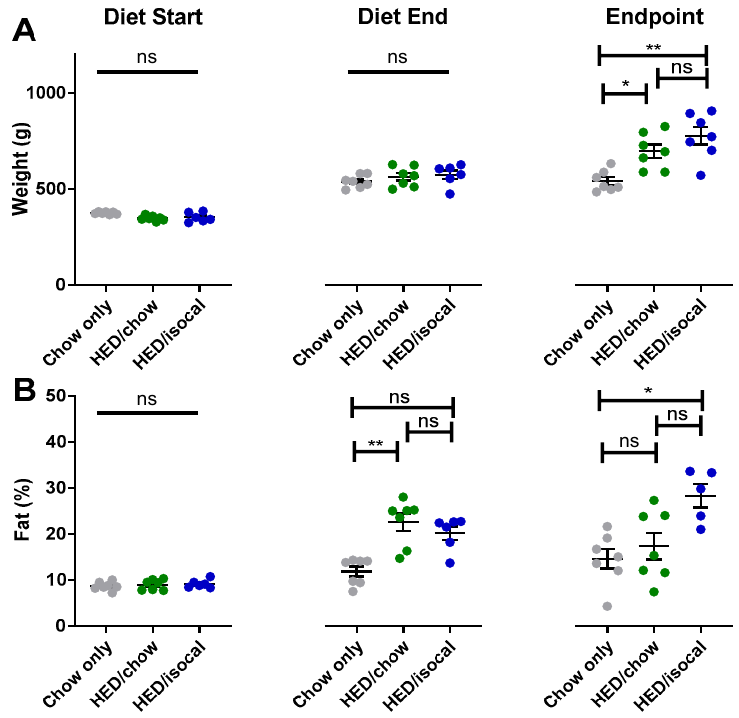
Figure 1. ( A ) Weight (g) of chow-only (grey, n = 7), HED/chow (green, n = 7) and HED/isocal (blue, n = 7) rats at the beginning of the first diet, after 10 weeks on HED or chow, and the endpoint/ day of tissue collection. ( B ) Percent body fat of chow-only (grey, n = 7), HED/chow (green, n = 7), and HED/isocal (blue, n = 6) rats at the beginning of the first diet, after 10 weeks on HED or chow, and the endpoint/day of tissue collection. Stars represent statistical significance, where * = p < 0.05; ** = p < 0.01; ns denotes non significant. Bars represent means plus/minus SEM. HED = high energy diet; isocal = isocalorically fed. Rats consuming chow-only had more fungiform papillae than those who consumed the HED, whether after being switched to chow ( p = 0.037), or continued to be fed a HED isocalorically ( p = 0.005). Even after 4 months consuming a chow diet, fungiform papillae did not recover to the level of chow fed counterparts. HED/chow and HED/isocal fed rats’ fungiform papilla density did not differ significantly ( p > 0.999) (Figure 2).